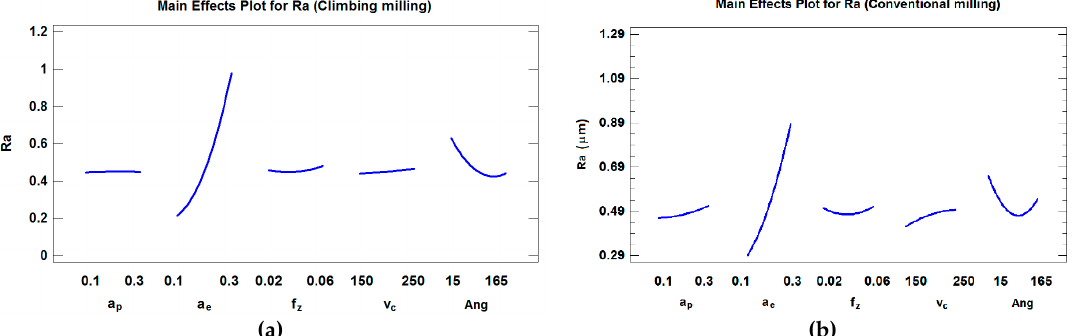
Figure 6. Main effects plot for Ra (considering the position angle) in ( a ) climb milling and ( b ) conventional milling.